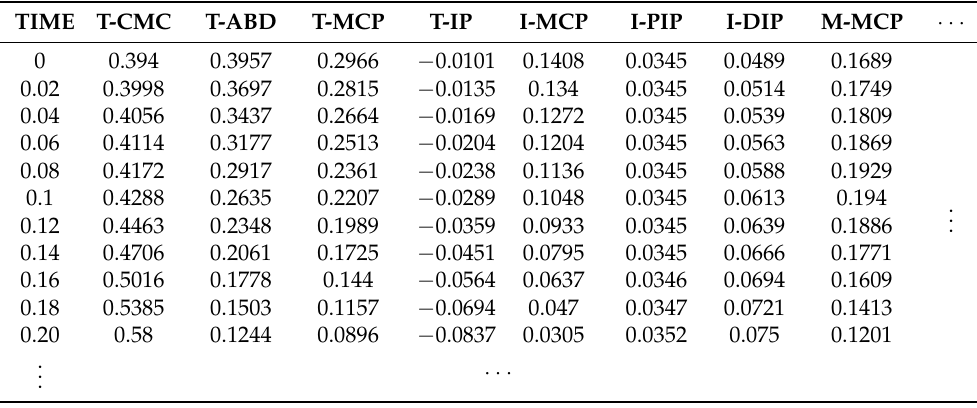
Table 2. Joint angle data in open